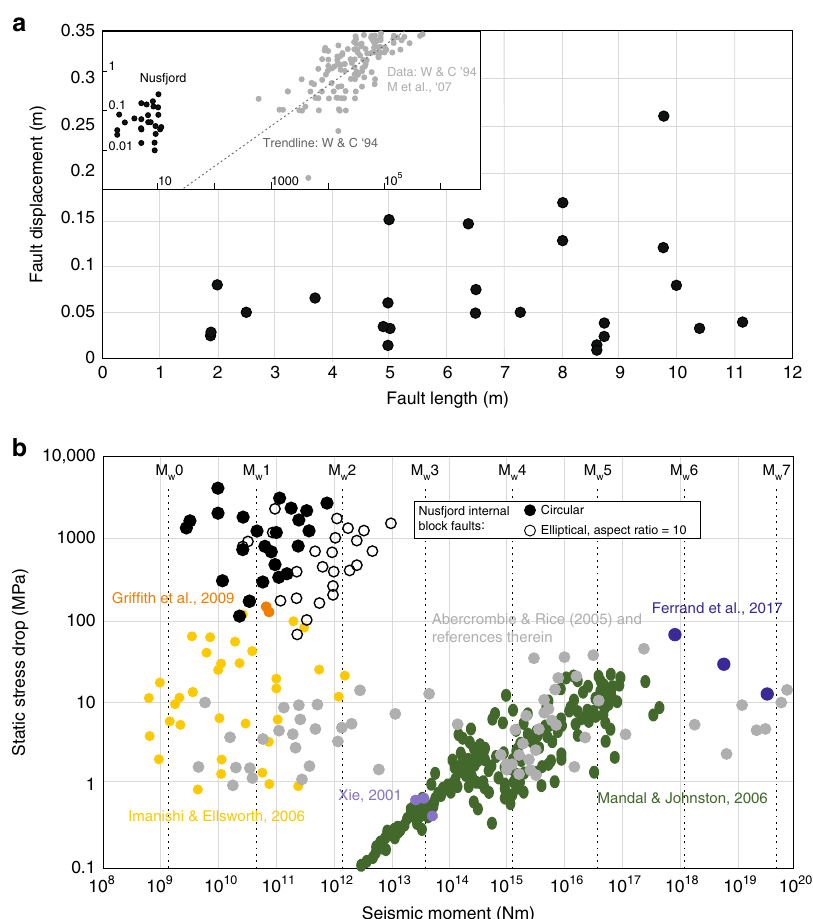
Fig. 4 Seismic source parameters of type-2 pseudotachylyte. a length vs displacement graph, inset compares Nusfjord type-2 pseudotachylytes with published data on rupture length versus displacement 22,33 ; b seismic moment vs static stress drop with equivalent moment magnitudes ( M w ) superimposed. The Nusfjord type-2 pseudotachylytes are shown in both the circular fault and elliptical fault cases (further elliptical aspect ratios are shown in Supplementary Fig. 5). Published seismologically determined data are included from small earthquakes at shallow depth on the San Andreas Fault 34 , intraplate aftershocks from 10 to 36 km depth occurring after the 2001 Bhuj (India) earthquake 37 , small earthquakes from the New Madrid seismic zone 36 , and small earthquakes recorded from the Park fi eld region of California 35 . Estimates from pseudotachylytes include an exhumed seismogenic fault zone in the Sierra Nevada that records seismogenic faulting at depths of 7 – 10 km 40 and a pseudotachylyte in lherzolites representing seismogenic faulting at >40 km 39